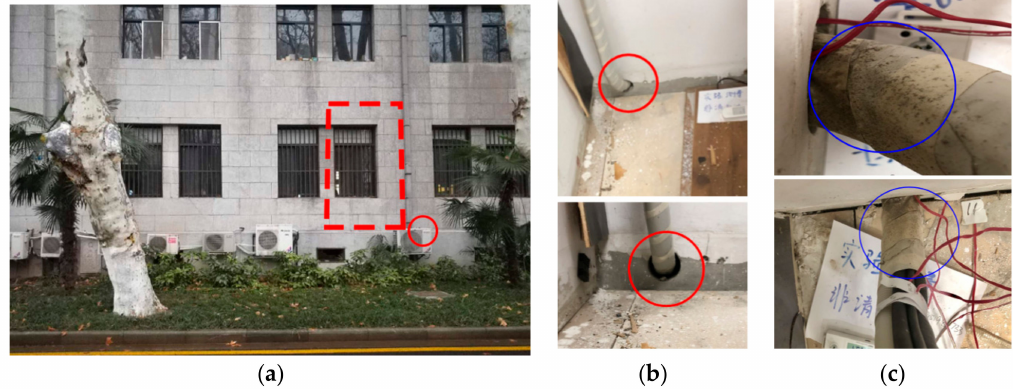
Figure 2. The monitored building and the monitored room: ( a ) The main facade of the monitored building and the monitored room (in red dashed line) with the air conditioner pipe hole, i.e., the air cavity (in red circle); ( b ) the air cavity in the monitored room without sealing; ( c ) mold colonization near the air cavity (in blue circle).